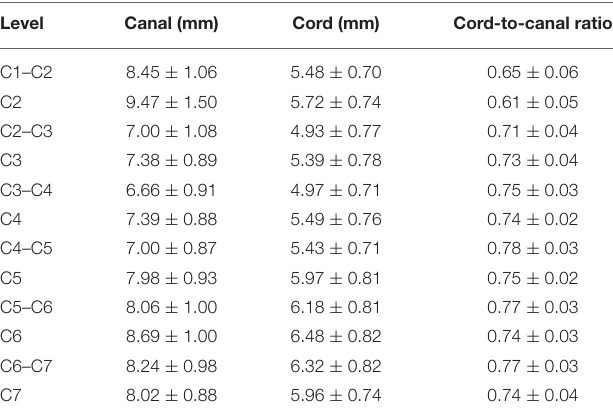
TABLE 1 | Heights of the spinal canal and cord measured on sagittal images and ratio of the height of the spinal cord to the canal.